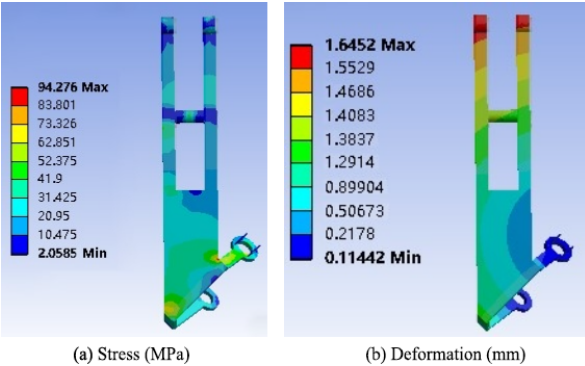
Figure 9. The cloud diagrams of the stress and deformation of the clamping arm of the rear frame. Table 2. The sixth-order modal frequencies of the frame